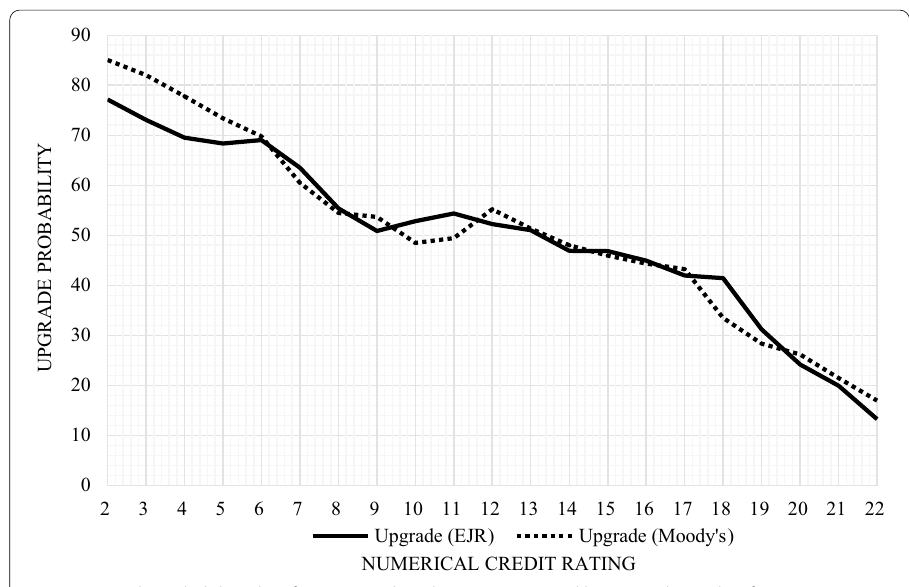
Fig. 4 Upgrade probability plots for numerical credit ratings assigned by EJR and Moody’s, from 2011 to